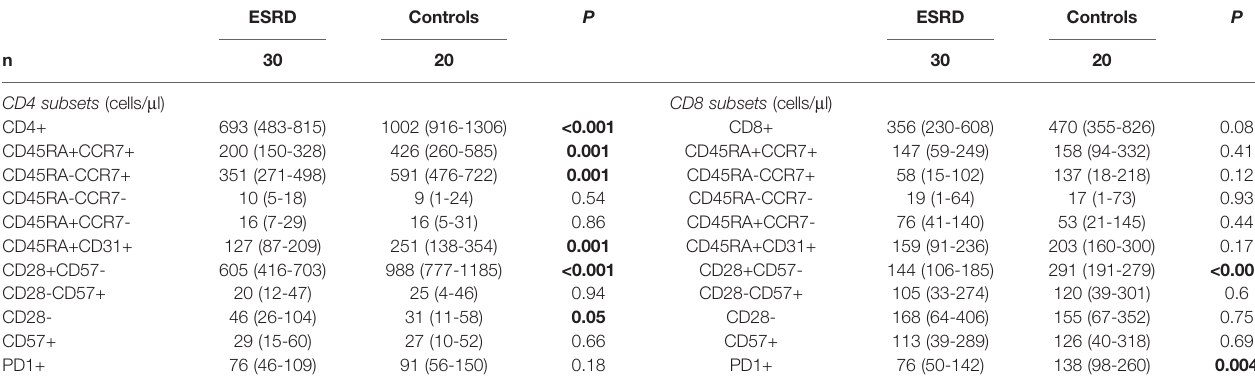
Bold values signify statistical signi fi cance.